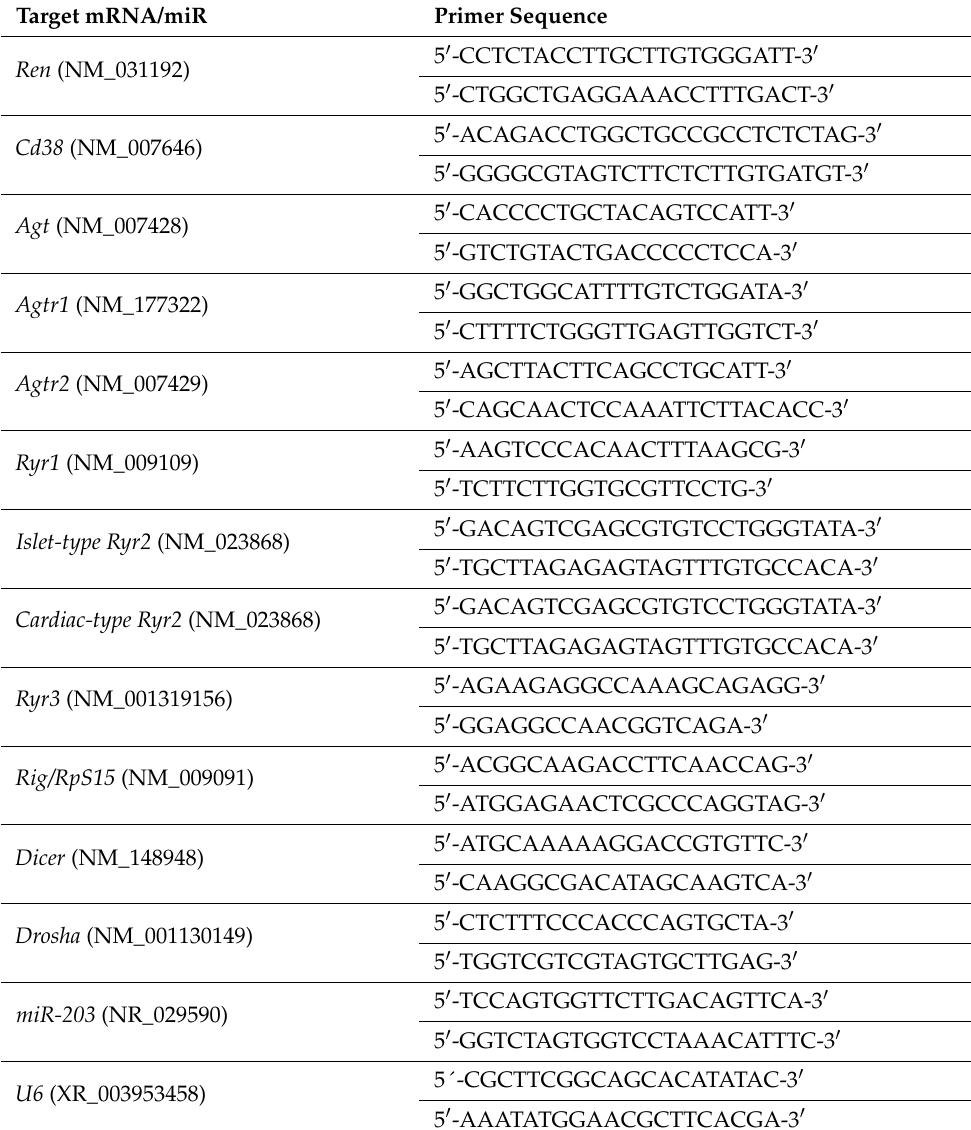
Table 2. PCR primers (mouse) for the real-time